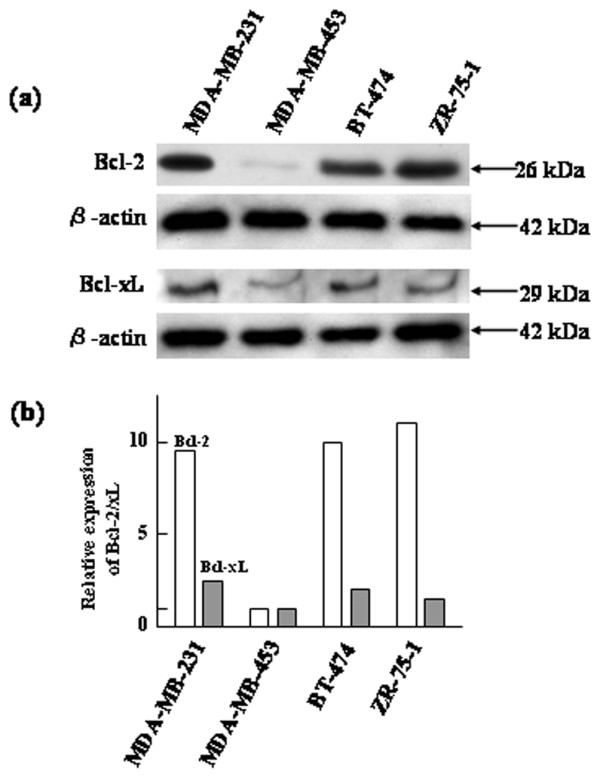
Expression levels of Bcl-2 and Bcl-xL proteins in MDA-MB-231, MDA-MD-453, BT-474, and ZR-75-1 cells. (a) Western blot analysis of Bcl-2 and Bcl-xL expression. (b) Quantification of Bcl-2 and Bcl-xL expression by densitometric analysis. The relative expression of Bcl-2 and Bcl-xL in MDA-MB-453 cells was compared with the expression in MDA-MB-231, BT-474, and ZR-75-1 cells. Results are from two representative, independent experiments.